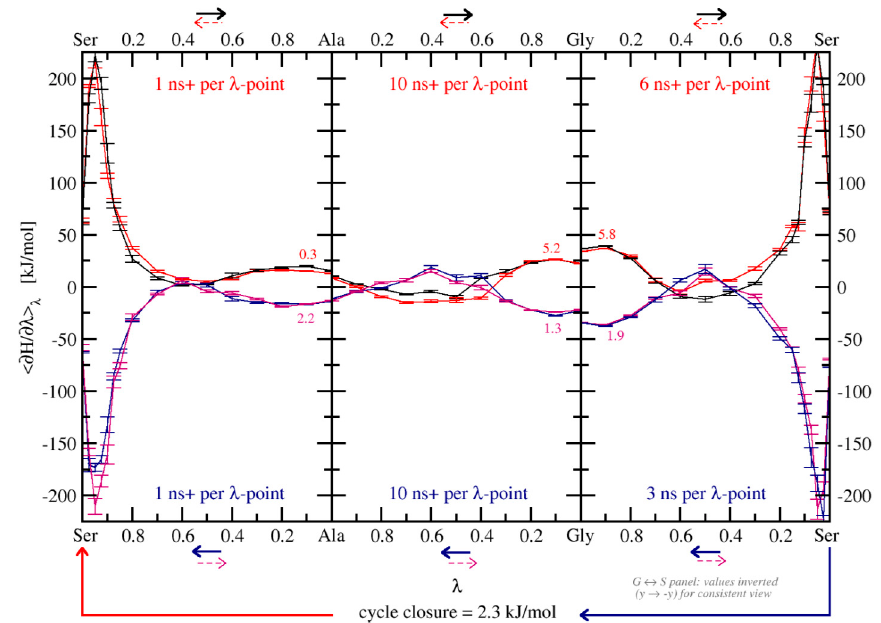
Figure 6. Final thermodynamic cycle in OppA. Black and blue lines are forward transformations, red and purple lines are backward transformations (reading direction according to the arrows above resp.